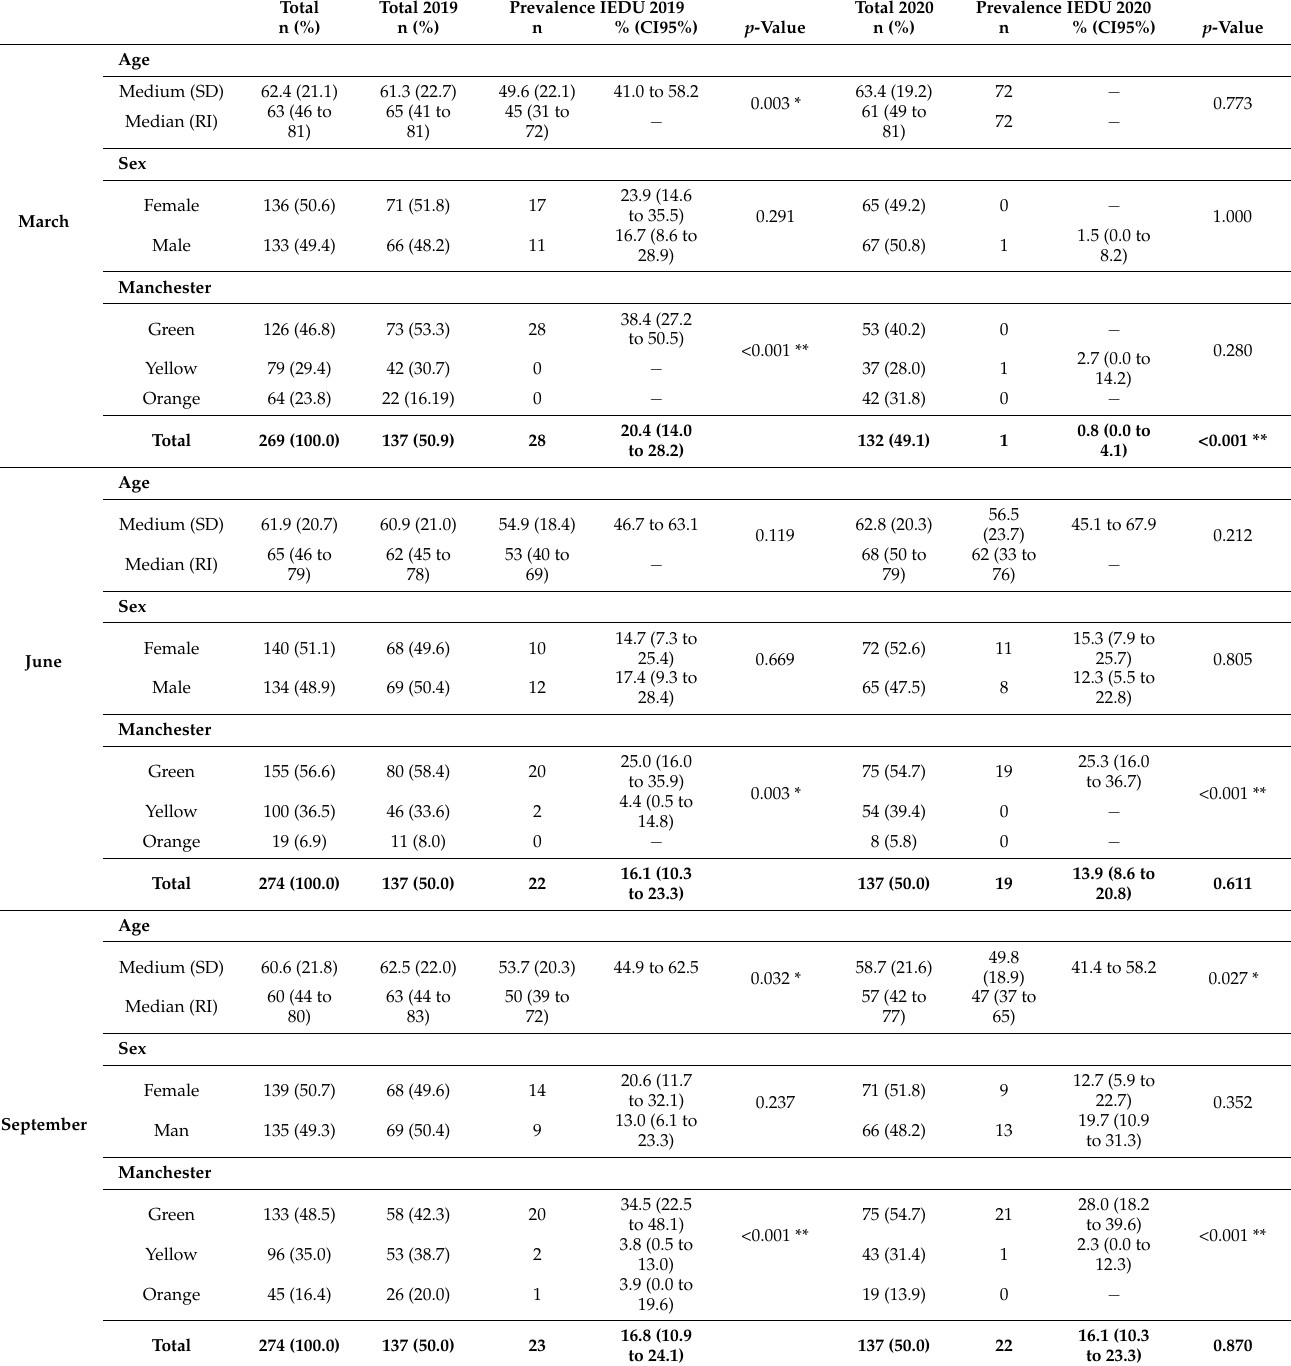
Table 1. Descriptive by study period and bivariate